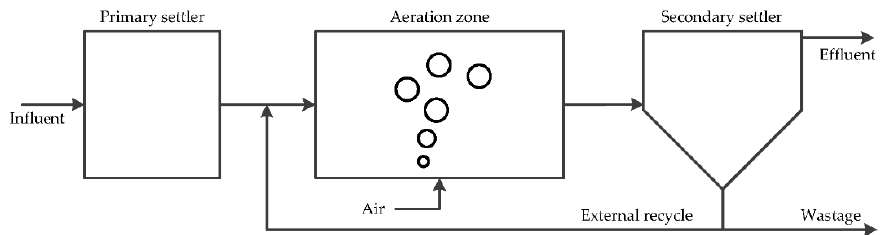
Figure 2. Basic processing blocks of the activated sludge process based wastewater treatment plants.